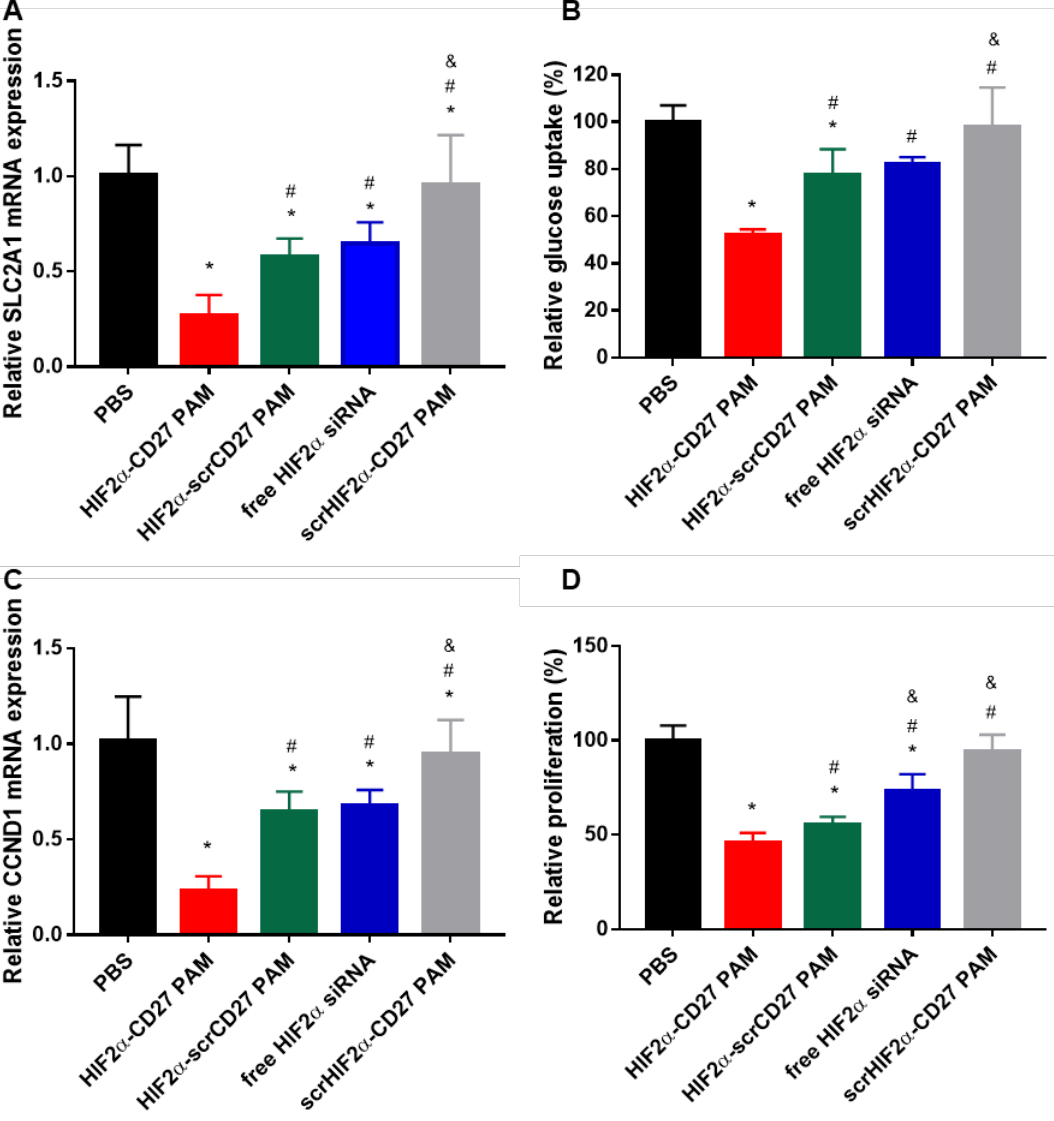
Figure 5. Gene knockdown and functional effects of HIF2 α -CD27 PAM treatment. 48 h HIF2 α -CD27 PAM treatment (500 nM siRNA) reduces ( A ) SLC2A1 mRNA expression and ( B ) glucose transport relative to non-targeted PAMs, free siRNA, and PBS in patient-derived ccRCC cells. HIF2 α -CD27 PAMs also reduce ( C ) CCND1 mRNA expression and ( D ) ccRCC proliferation 5 d following treatment. N = 4–6. * p < 0.05 relative to PBS. # p < 0.05 relative to HIF2 α -CD27 PAMs. & p < 0.05 relative to HIF2α -scrCD27 PAMs.